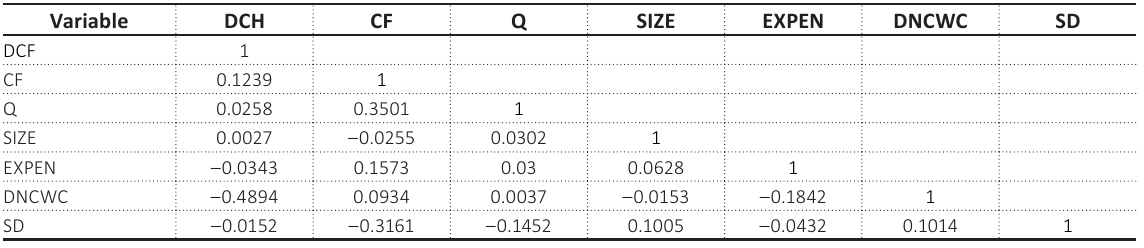
Source: Authors’ calculations from Stata